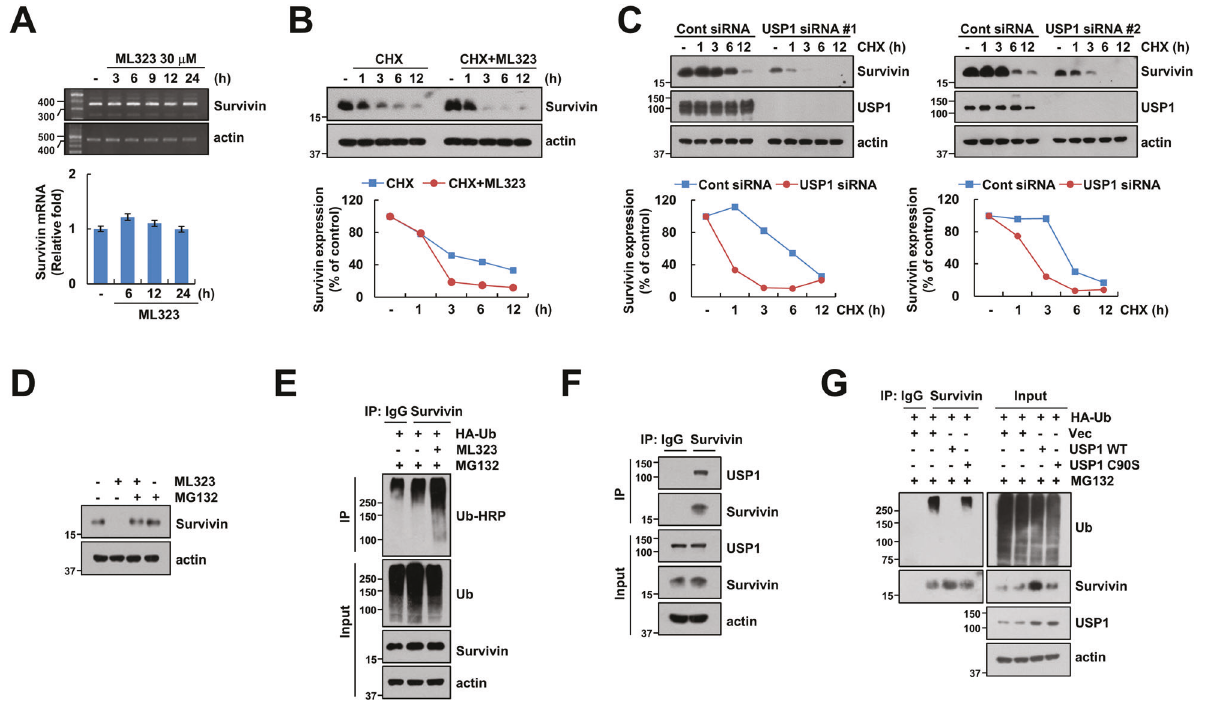
Fig. 2 USP1 directly interacts and induces deubiquitination of survivin. A Caki-1 cells were treated with 30 μ M ML323 for the indicated time periods, and survivin mRNA expression were analyzed using RT-PCR and qPCR. B Caki-1 cells were pretreated with 20 μ g/mL cycloheximide (CHX) for 30 min and then treated with 30 μ M ML323 for the indicated time periods. C Caki-1 cells were transfected with control siRNA or USP1 siRNA followed by treatment with 20 μ g/mL CHX for the indicated time periods. D Caki-1 cells were pretreated with 0.25 μ M MG132 for 30 min and then treated with 30 μ M ML323 for 24 h. E Caki-1 cells were transfected with the HA-ubiquitin (HA-Ub) followed by combinations of 0.25 μ M MG132 and 30 μ M ML323 for 12 h. Ubiquitination assay of survivin was performed using an anti-survivin antibody. F Investigation of interaction between USP1 and survivin for IP assay using an anti-survivin antibody. G Caki-1 cells were transfected with vector, USP1 WT or USP1 C90S and HA-ubiquitin followed by 0.25 μ M MG132 for 12 h. Protein expression was measured using western blotting ( B – G ). The band intensity of survivin protein was quanti fi ed by using